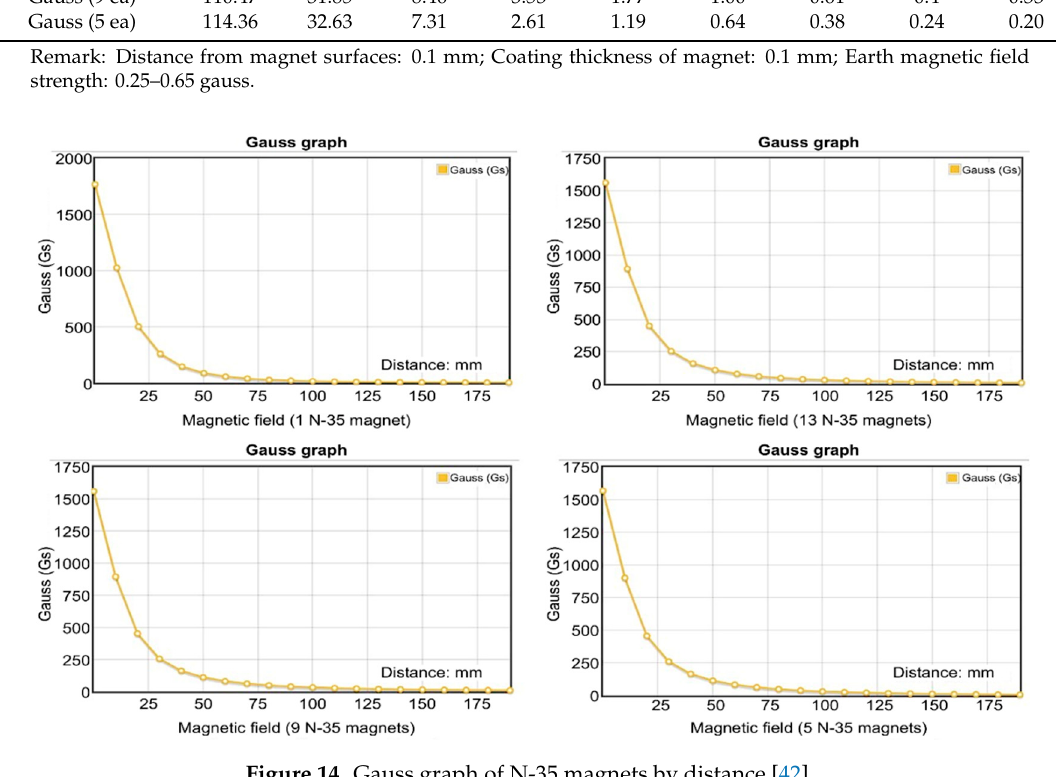
Figure 14. Gauss graph of N-35 magnets by distance [42]. Table 6. Gauss calculation by distance [42]. Type and Size of Magnet